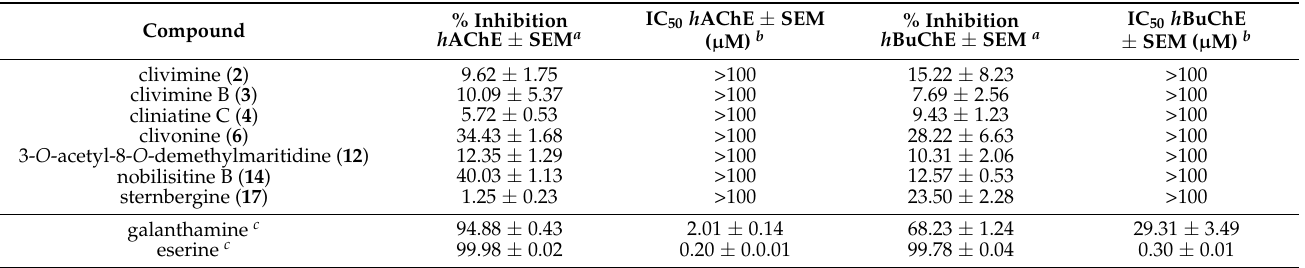
Table 2. In vitro results of h AChE and h BuChE inhibition assays of previously untested AAs isolated from Clivia miniata